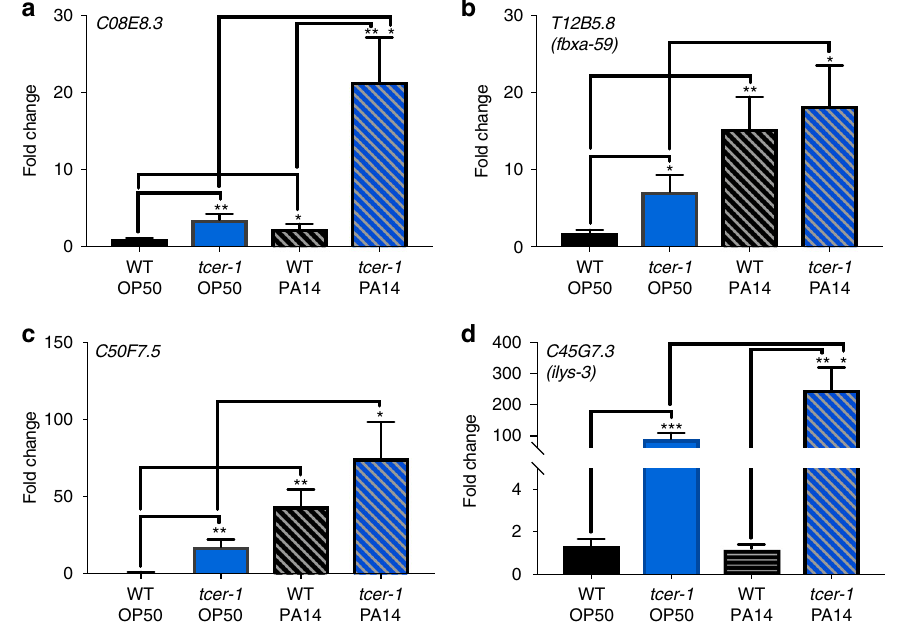
Fig. 6 TCER-1 inhibits immunity by repressing PMK-1- independent genes. Gene expression measured by Q-PCRs of wild-type animals (black) and tcer-1 mutants (blue) grown on OP50 till L4 stage and then exposed to PA14 (hashed bars) or retained on OP50 for 12 h. a – d Expression of PMK-1-independent immunity genes C08E8.3 ( a ), fbxa-59 ( b ), C50F7.5 ( c ) and ilys-3 ( d ). Data combined from 2 to 5 independent biological replicates, each including three technical replicates. Statistical signi fi cance of the differences in expression was calculated using a one-tailed t test. Error bars represent standard error of the mean. * P < 0.05, ** P < 0.01, *** P <